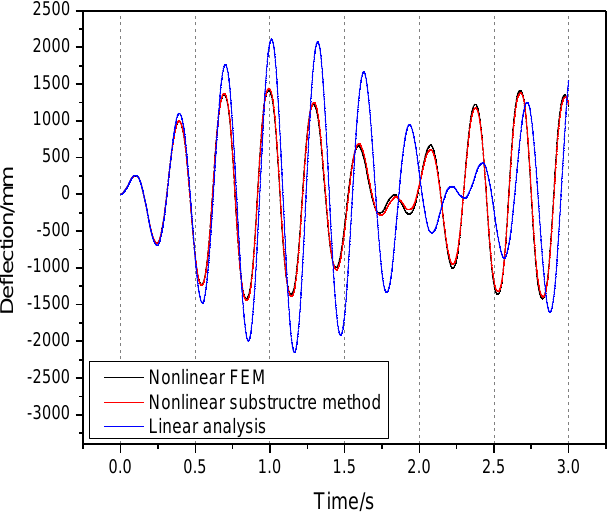
= 20 N and f = 3 Hz. 0